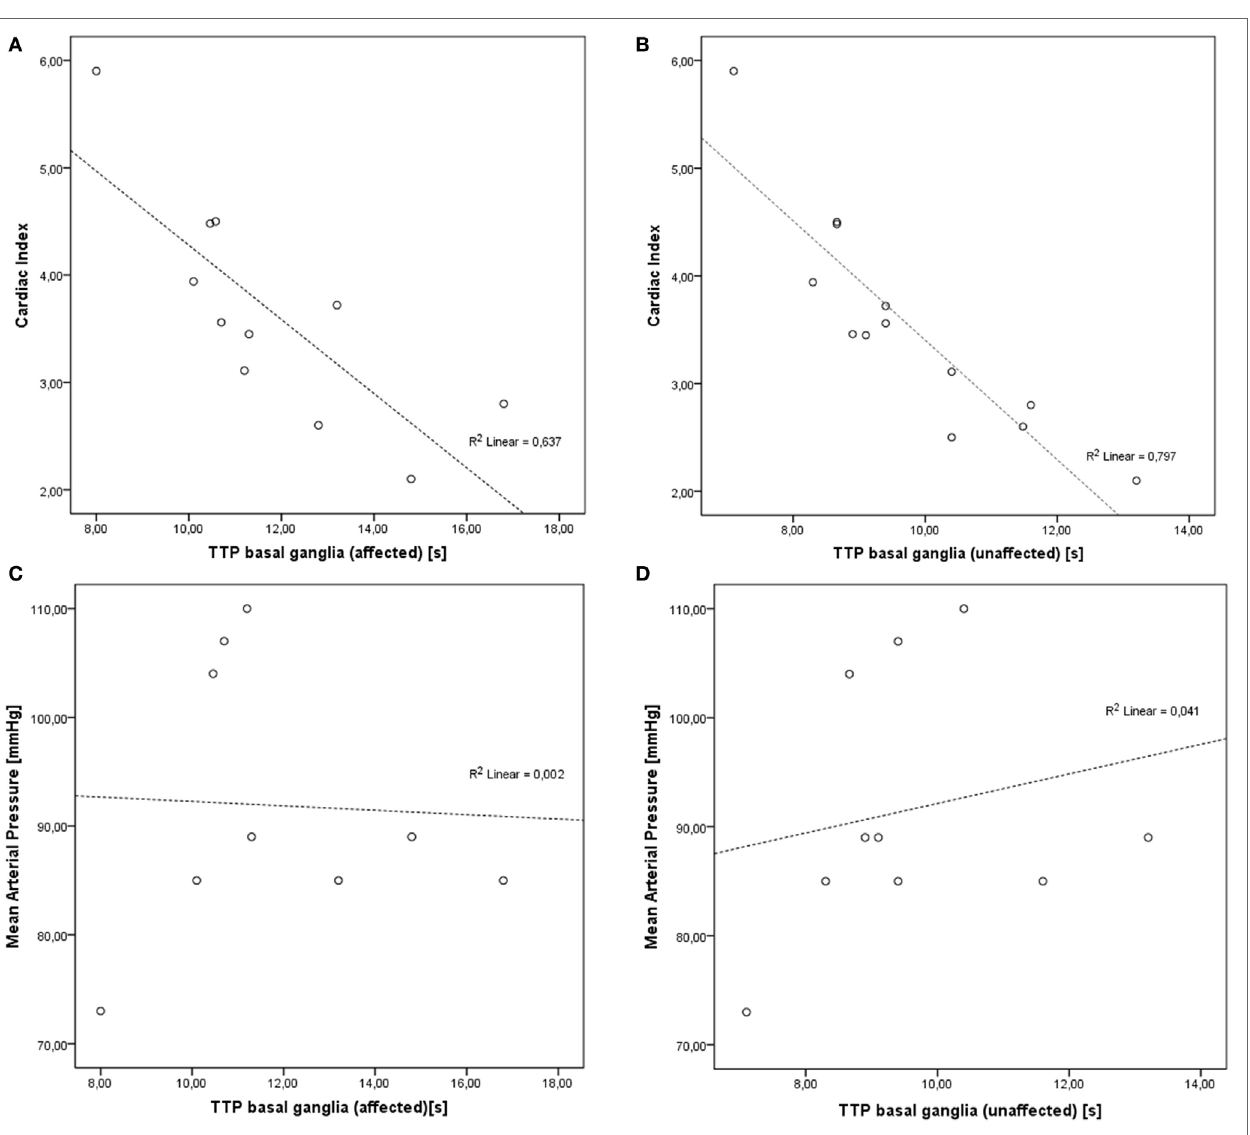
FigUre 1 | Correlations of cardiac index (CI) and mean arterial pressure (MAP) levels and time-to-peak (TTP) values. (a) Inverse correlation of CI and TTP in affected basal ganglia ( r = − 0.798, p < 0.001). (B) Inverse correlation of CI and TTP in unaffected basal ganglia ( r = − 0.893, p < 0.0001). (c) No significant correlation of MAP and affected basal ganglia ( r = − 0.044, p = 0.911). (D) No significant correlation of MAP and unaffected basal ganglia ( r = 0.202, p =